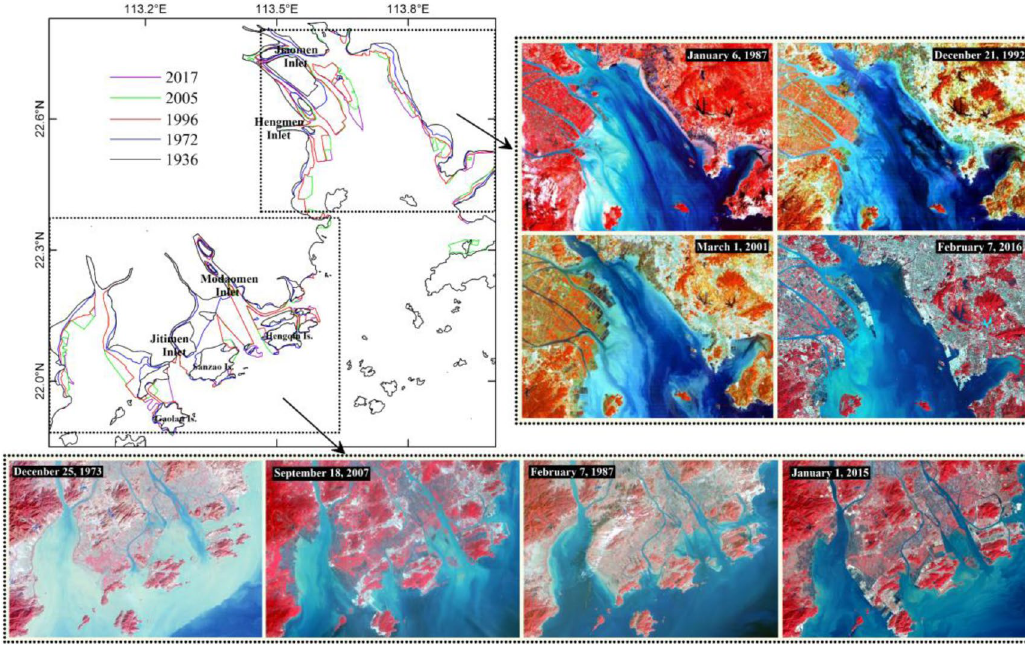
Figure 2. Coastline evolution in the Pearl River Estuary for 1936–2017 and comparison of the coastline of the sub-regions at different times. Maps were created with Surfer, Version 13, https:// www. golde nsoft ware. com/ produ cts/ surfer, ENVI, Version 5.3, http:// www. envii dl.